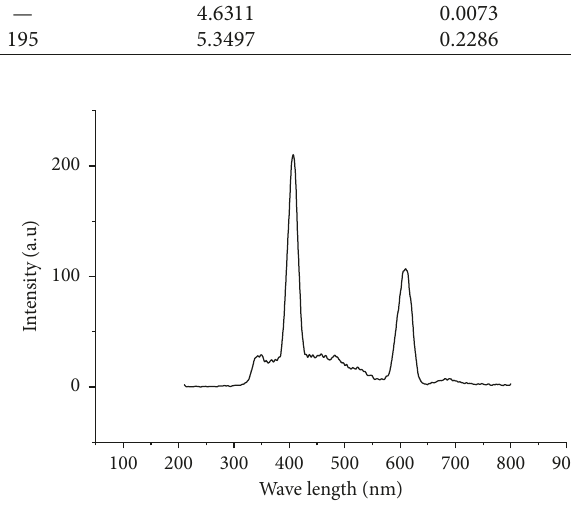
Figure 12: Photoluminescence emission spectra of BDSC.